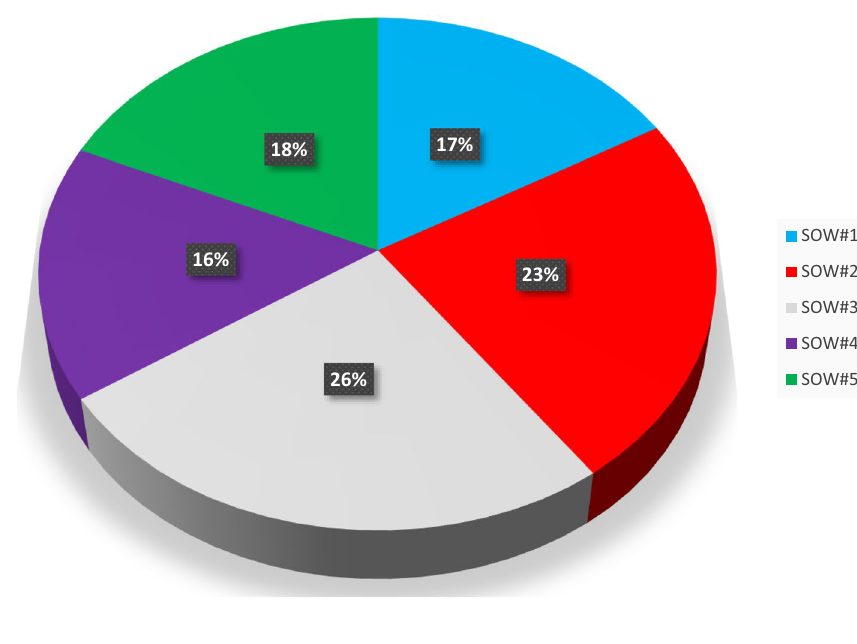
water in each shale oil well in MMSCF/Day during drilling mud preparation and other suitable facilities